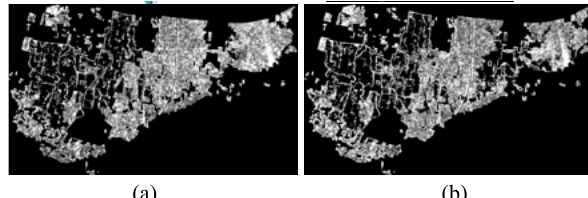
Figure 7. Dataset for verifying detected flooded area. (a) Ortho- mosaic image covering 80-ha of Tegalluar area in Bojongsoang, which was acquired by the UAV mounting the near-infrared camera on Feb.27. (b) and (c) Examples of ground photos taken by the pest observer in Bojongsoang.